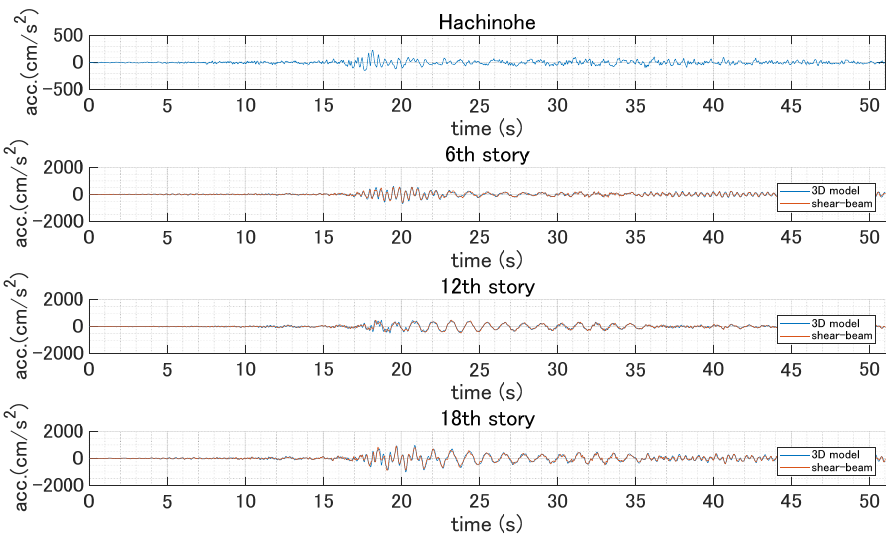
Figure 6. Comparison of response accelerations between the 3D and simplified planar model ( y - direction).